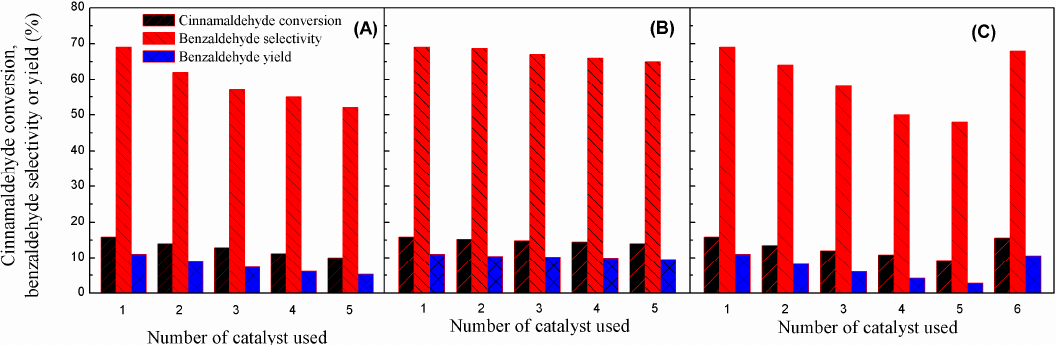
Figure 6. Recyclability data of the Zr–ZnO catalyst for cinnamaldehyde oxidation (( A ) filtration, washing, and desiccation; ( B ) desiccation and calcination; ( C ) no treatment). Reaction conditions: 0.01 g Zr–ZnO, 8.0 g ethanol and 2.0 g cinnamaldehyde reacted at an oxygen pressure of 1.0 MPa and 70 °C for 60 min.